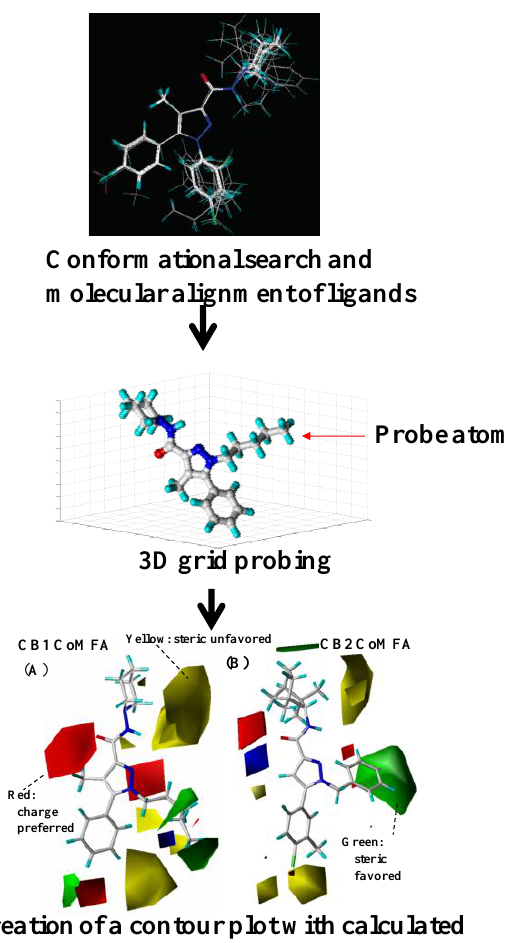
Creation of a contour plot with calculated steric and electrostatic fields